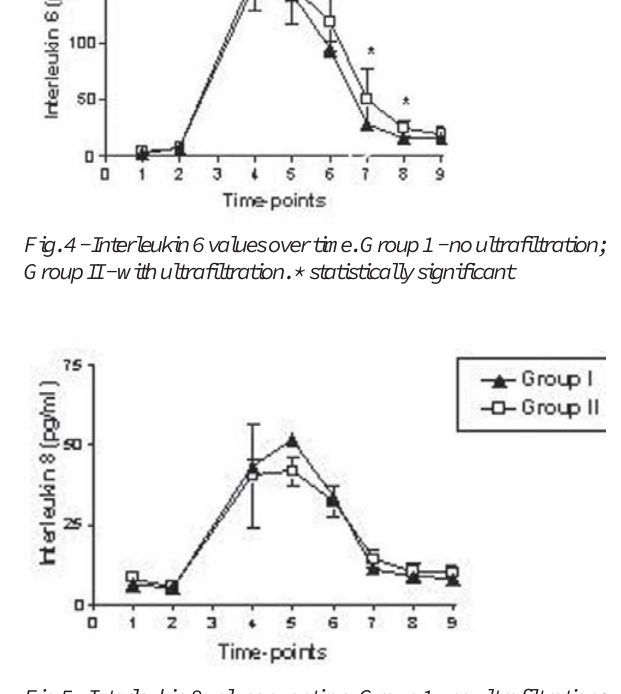
Fig.5 - Interleukin 8 values over time. Group 1 - no ultrafiltration; Group II - with ultrafiltration. * statistically significant